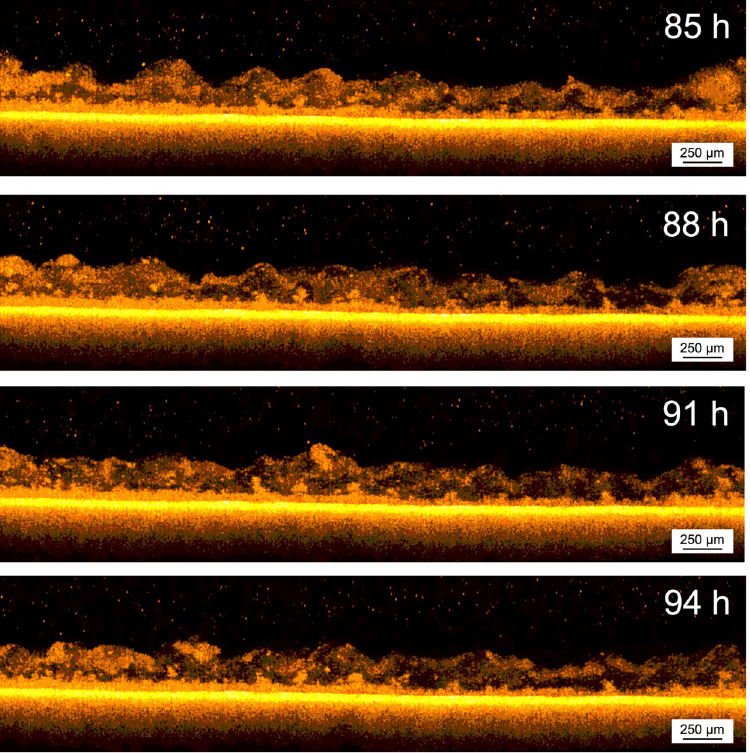
Figure 5. OCT cross-sectional scans of the double layer biofouling morphology. The scans were acquired with a frequency of 5 min from 84 to 96 h of the experiment. The lower layer remains constant while the upper one moves (See Supplementary Video 2).